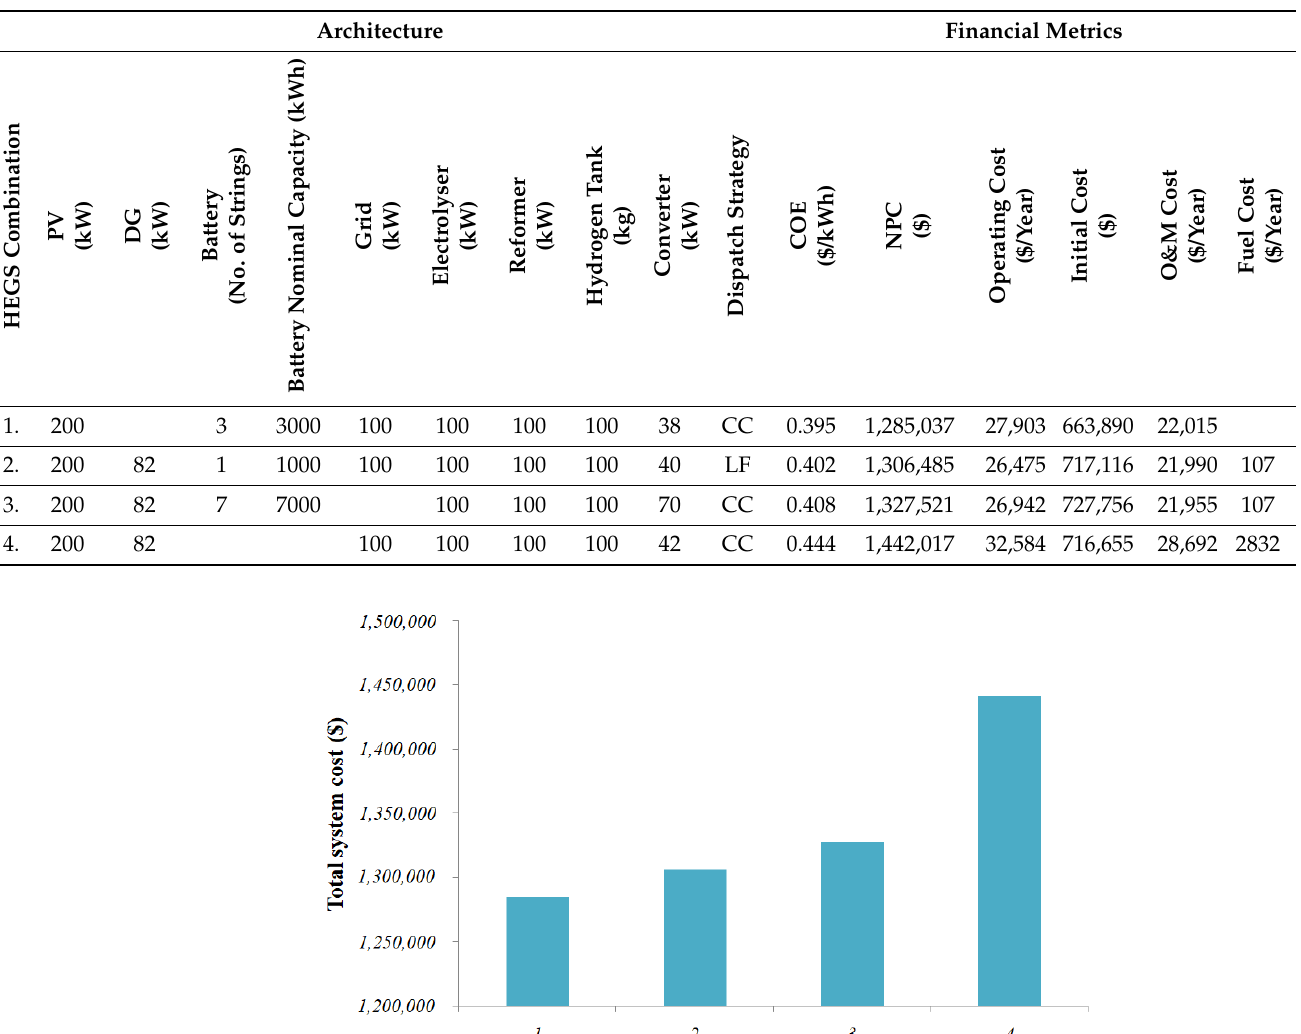
Table 5. Optimization results obtained for proposed HEGS (Part—I).